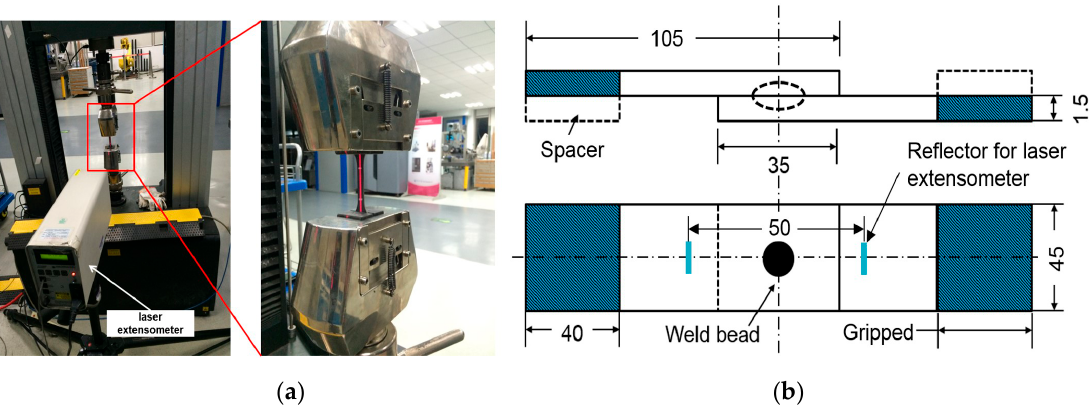
Figure 3. ( a ) The device used to measure the strain using the laser extensometer. ( b ) Major nominal dimensions of the lap shear test sample (unit: mm).